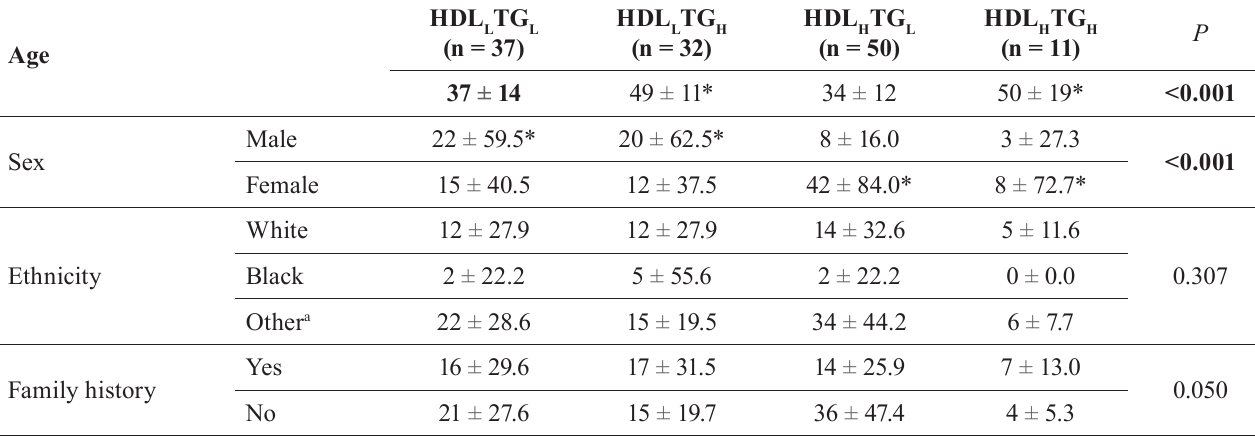
TABLE I - D emographic and clinical profile of subjects